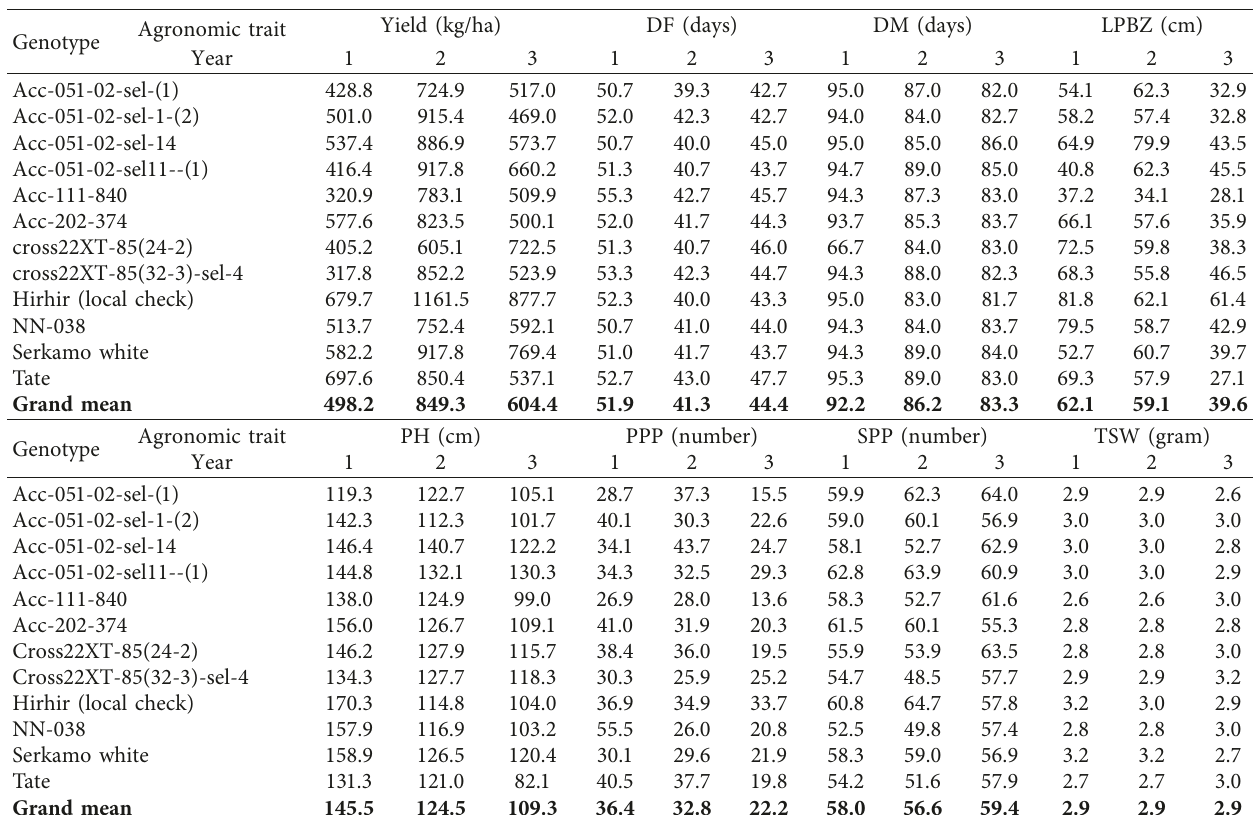
Table 6: Yield and yield components of sesame genotypes evaluated in the three growing years. Genotype